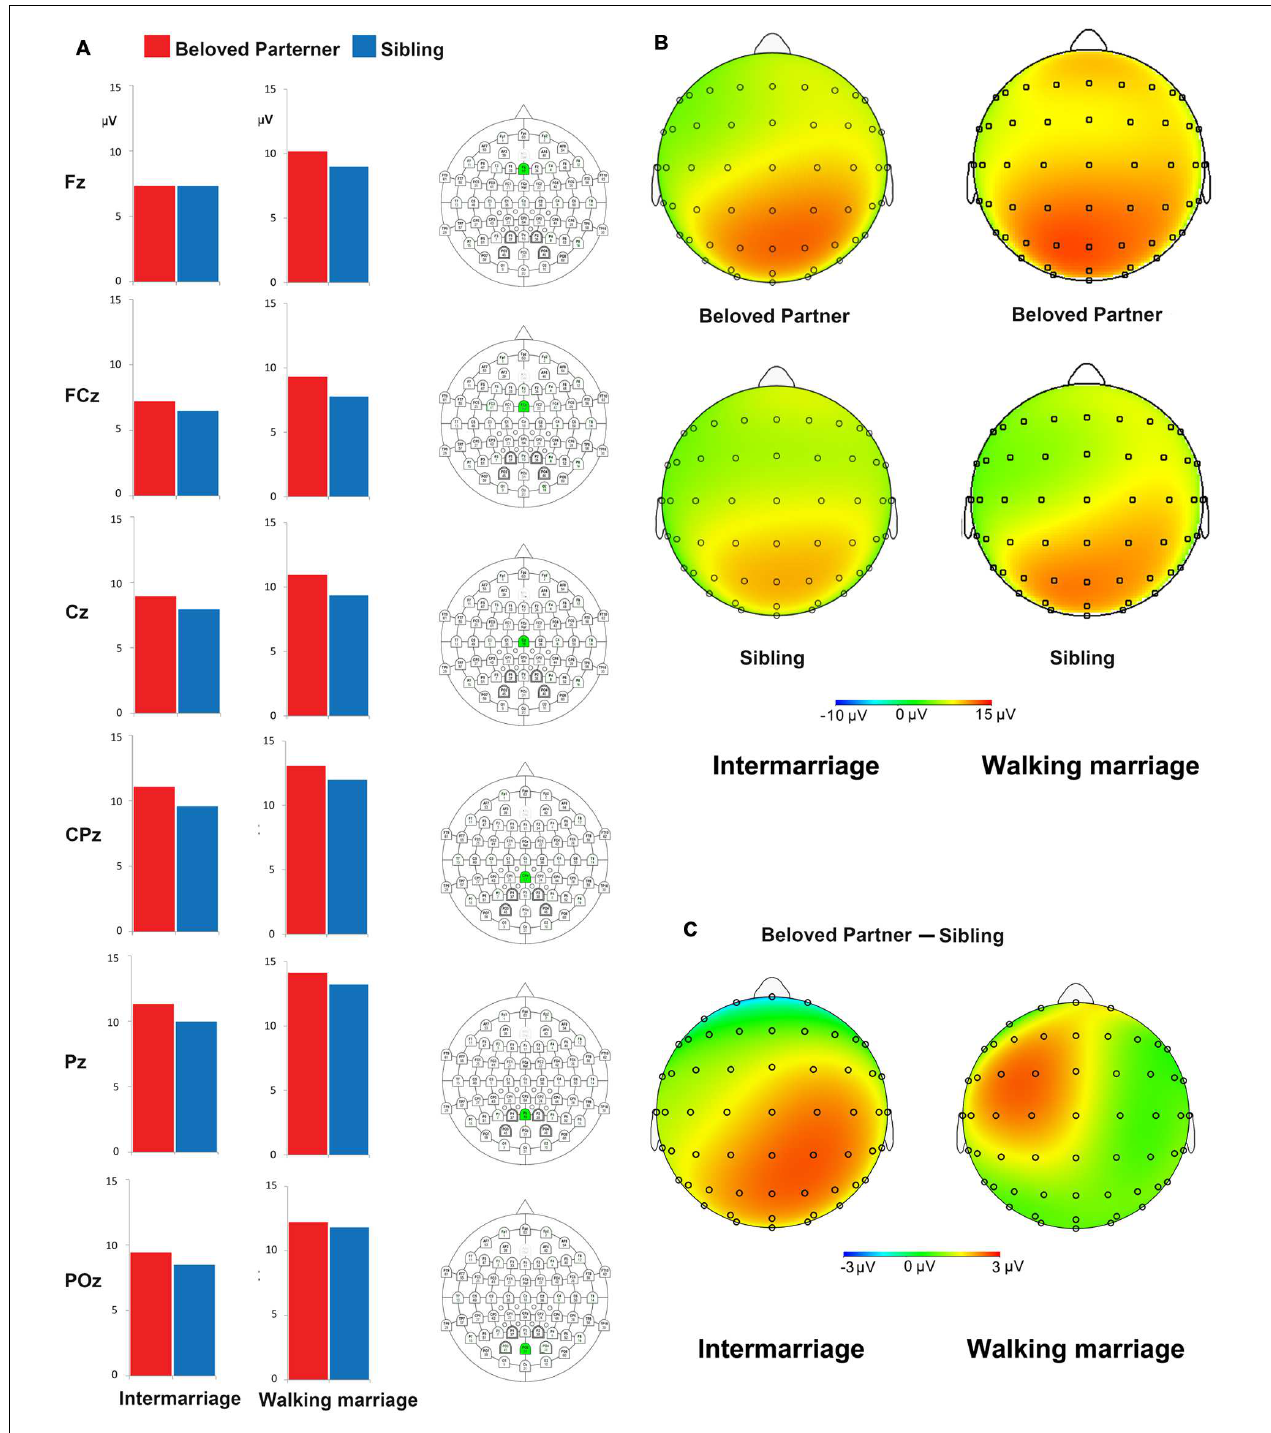
FIGURE 2 | (A) The P300 amplitude in the midline electrodes. The bars indicates the mean P300 amplitude at Fz, FCz, Cz, CPz, Pz, and POz (corresponding electrode was marked as green in column III); (B) The topography of P300 for grand averaged face conditions (beloved partner vs. sibling) for two groups; (C) The topography of difference wave of P300 (beloved partner vs. sibling) for two groups. The topography map indicated that the beloved partner vs. sibling P300 difference mainly occurs at posterior sites (also at some frontal sites) for intermarriage group while the difference only occurs at anterior sites for walking marriage group. The figure indicates that the beloved partner vs. sibling difference changes from the anterior to posterior sites. Such difference is larger at posterior sites for intermarriage group, while the difference is larger at anterior sites for walking marriage group.